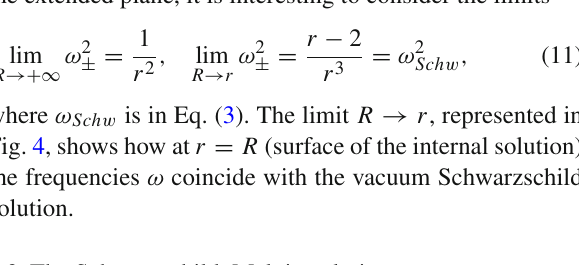
Fig. 4 Left panel: Interior Schwarzschild geometry ( M = 1 ) of Eq. (9). Metric bundles in the plane R − r where R is the surface radius with vanishing pressure. ω is the bundle characteristic frequency. The purple curve corresponds to light-like orbital frequency ω = 0. The √ radius R a ≡ 3 2 r 2 / 3 is also plotted as a black curve. The interior solu- tion is for r < R . The radius r γ is the last circular photon circular